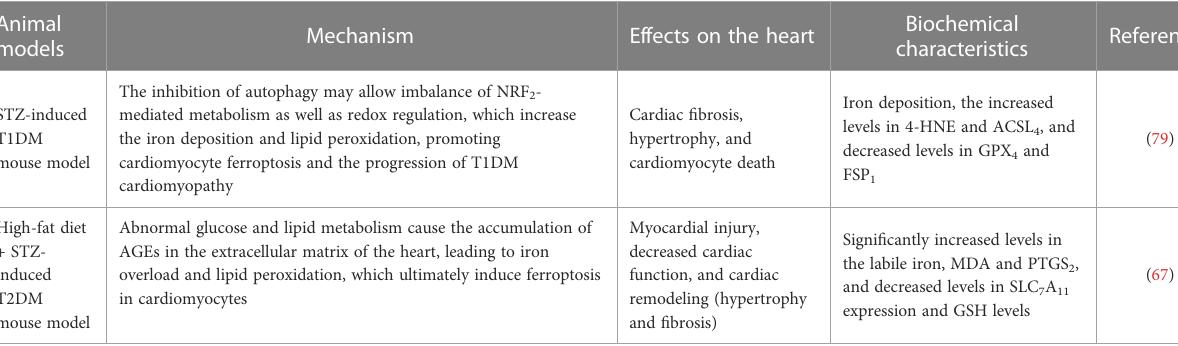
TABLE 1 The performance of ferroptosis in different types of animal models of diabetes. Animal models